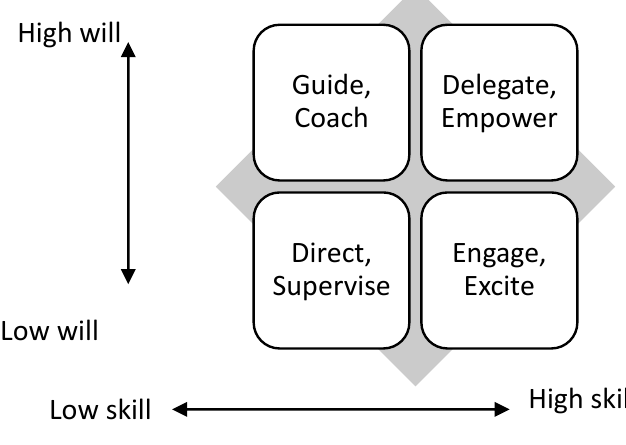
Figure 3. The skill-will matrix